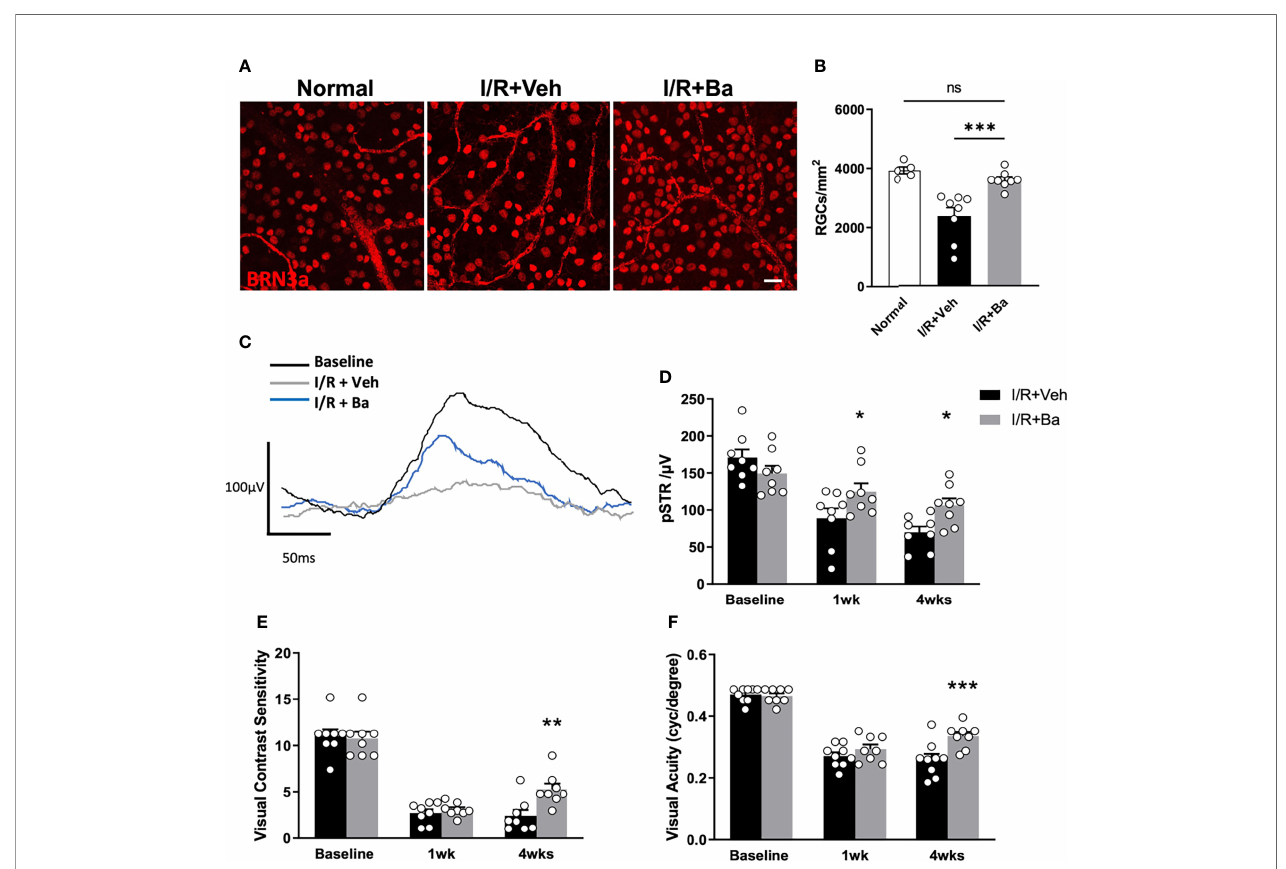
FIGURE 6 | Therapeutic administration of baicalein rescues retinal ganglion cells (RGCs) and visual functions in retinal I/R mice model. (A) Representative immuno fl uorescence photomicrographs of BRN-3a-labeled RGCs (red) and (B) quanti fi cation of surviving RGCs in whole-mounted retina from normal mice and vehicle or 100 m M baicalein (Ba)-treated mice at 4 weeks post-I/R injury. Scale bar = 20 m m. Representative waveforms (C) and quanti fi cation (D) of pSTR in vehicle or 100 m M baicalein-treated mice at 0, 1, and 4 weeks post-I/R injury. Line color: black = baseline, blue = I/R + 100 m M Ba, and gray = I/R + Veh. Spatial vision of (E) visual contrast sensitivity and (F) visual acuity from vehicle or 100 m M baicalein-treated mice at 1 and 4 weeks post-I/R injury were shown. N = 8 – 9/group. Data were presented as mean ± SEM. Each dot represented individual replicates. ns, non-signi fi cant difference; * P < 0.05, ** P < 0.01, *** P < 0.001, two-way ANOVA with S ̌ ı ́ da ́ k ’ s multiple comparisons